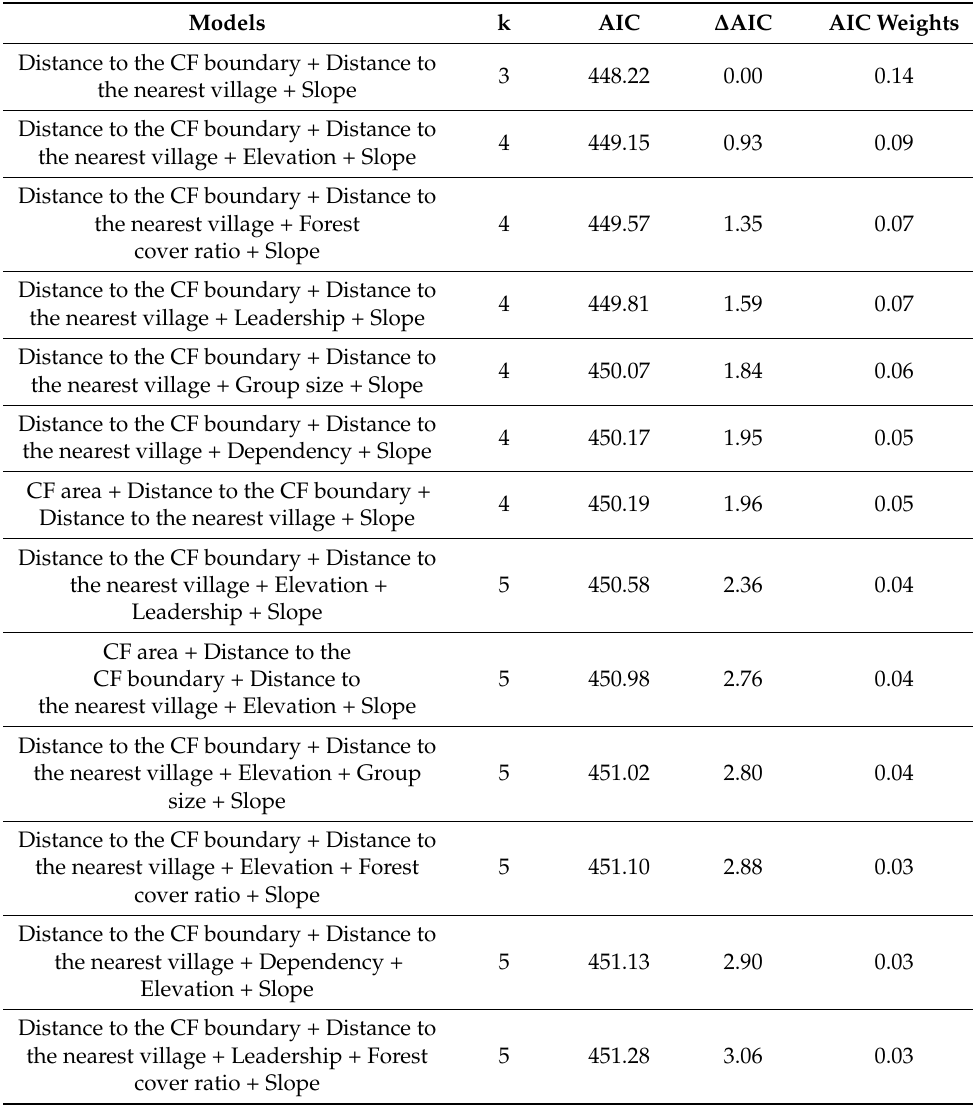
Table 3. AIC model ranking of the component